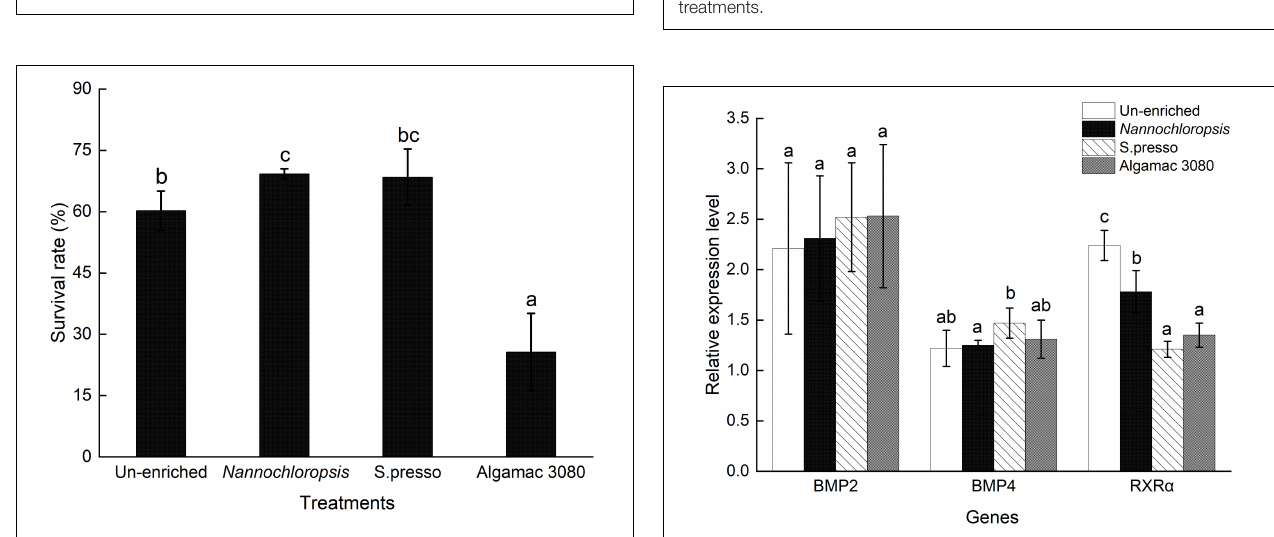
FIGURE 5 | Relative expression level of bone morphogenetic protein 2 (BMP2), bone morphogenetic protein 4 (BMP4), and retinoid X receptor α (RXR α ) genes of golden pompano larvae in four enrichment